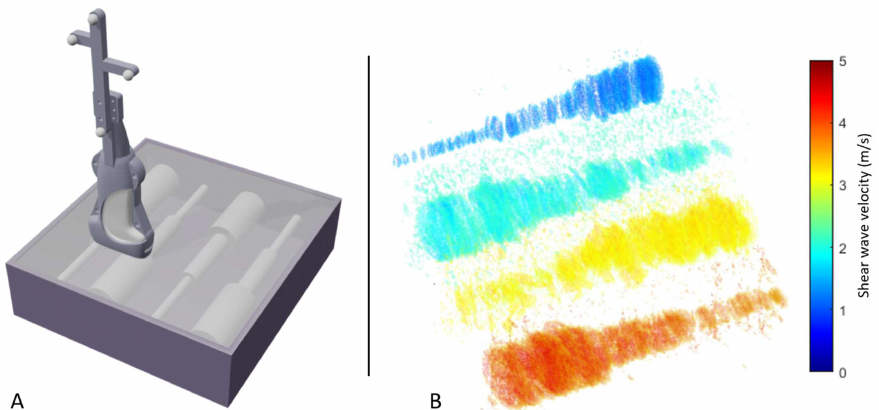
Figure 3. Elastography phantom scan. ( A ) Schematic depiction of the procedure used to validate 3D shear wave velocity on an elastography phantom including discrete targets of known stiffness. The phantom was scanned with the US transducer oriented orthogonal to the contained cylinders and volumetric mapping was implemented using a motion capture system and a reflective marker set attached to the transducer. ( B ) Heatmap visualization of the volumetric shear wave velocity reconstruction of the four inclusions.